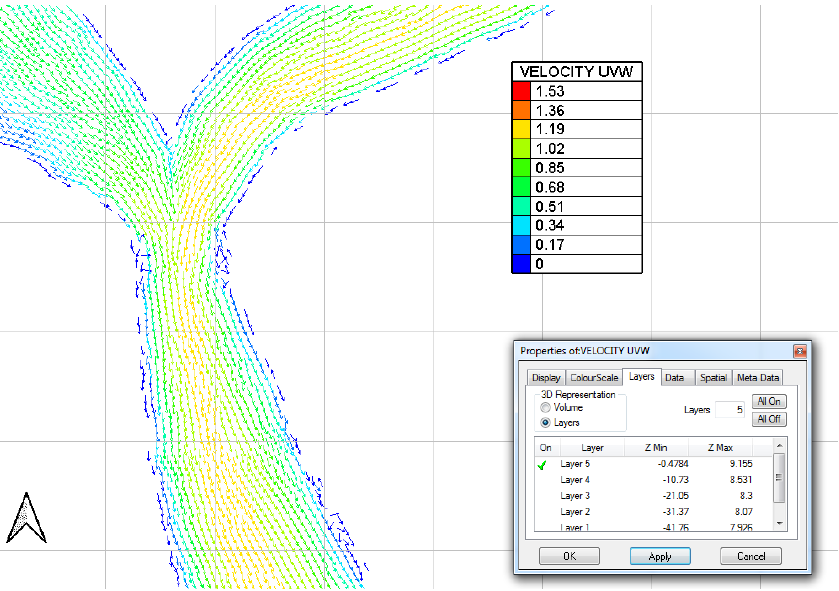
Figure 12. Average flow velocity (VELOCITY UV) in the flood season in 2017 at the surface (m/s).